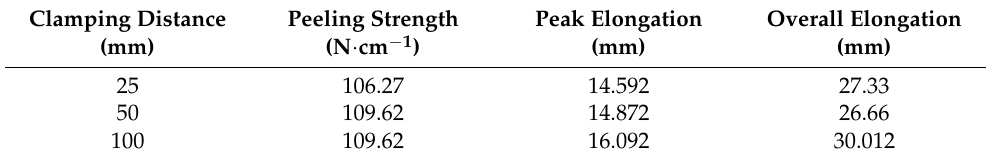
Table 5. Peeling test results of the